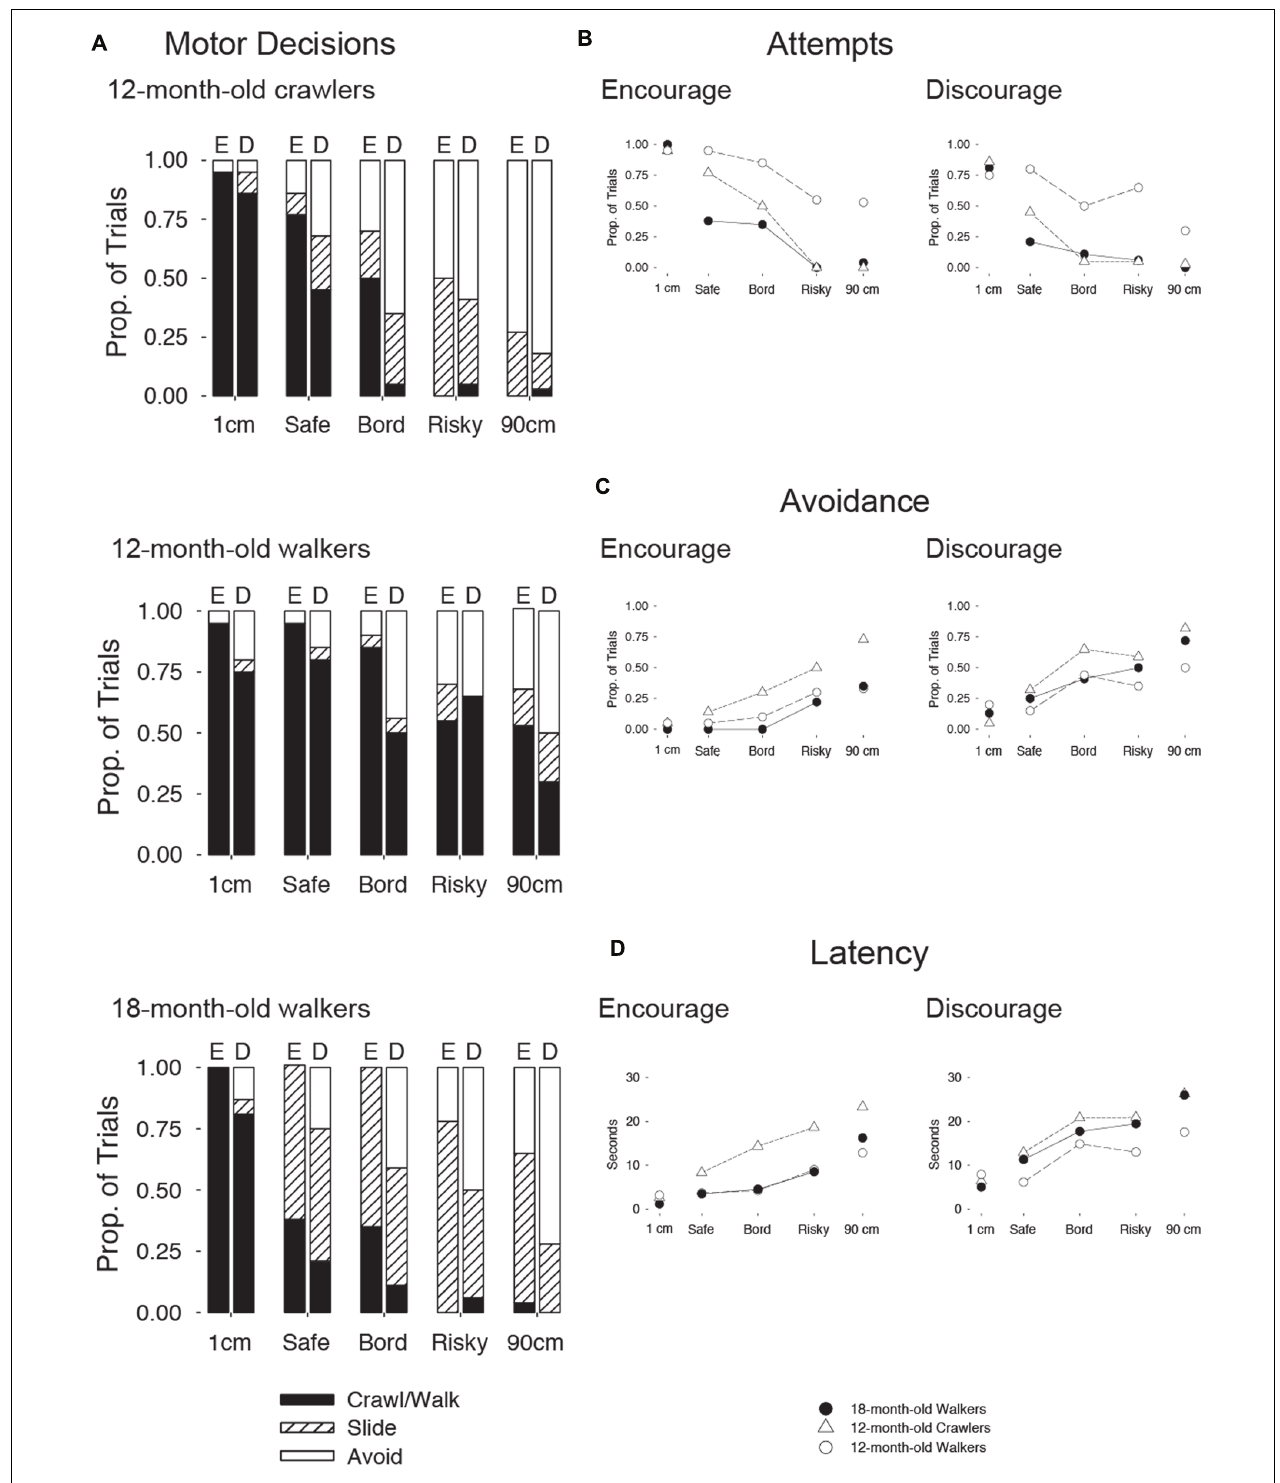
FIGURE 3 | (A) Stacked bar graphs show the average proportion of trials in, which 12-month-old experienced crawlers, 12-month-old novice walkers, and 18-month-old experienced walkers attempted to crawl or walk (black bars), used alternative descent strategies (striped bars), or avoided descent (white bars) in the encouraging “E” and discouraging “D” conditions. The x-axis is labeled with five drop-off increments in order of increasing risk: 1-cm, safe ( − 6-cm smaller than infants’ borderline drop-off), borderline drop-off, risky ( + 6-cm larger than infants’ borderline drop-off), and 90-cm drop-off. Line graphs show (B) proportion of trials in which infants attempted to crawl or walk and (C) avoid. (D) Latency (seconds) graphs show hesitation on the starting platform in each locomotor group.